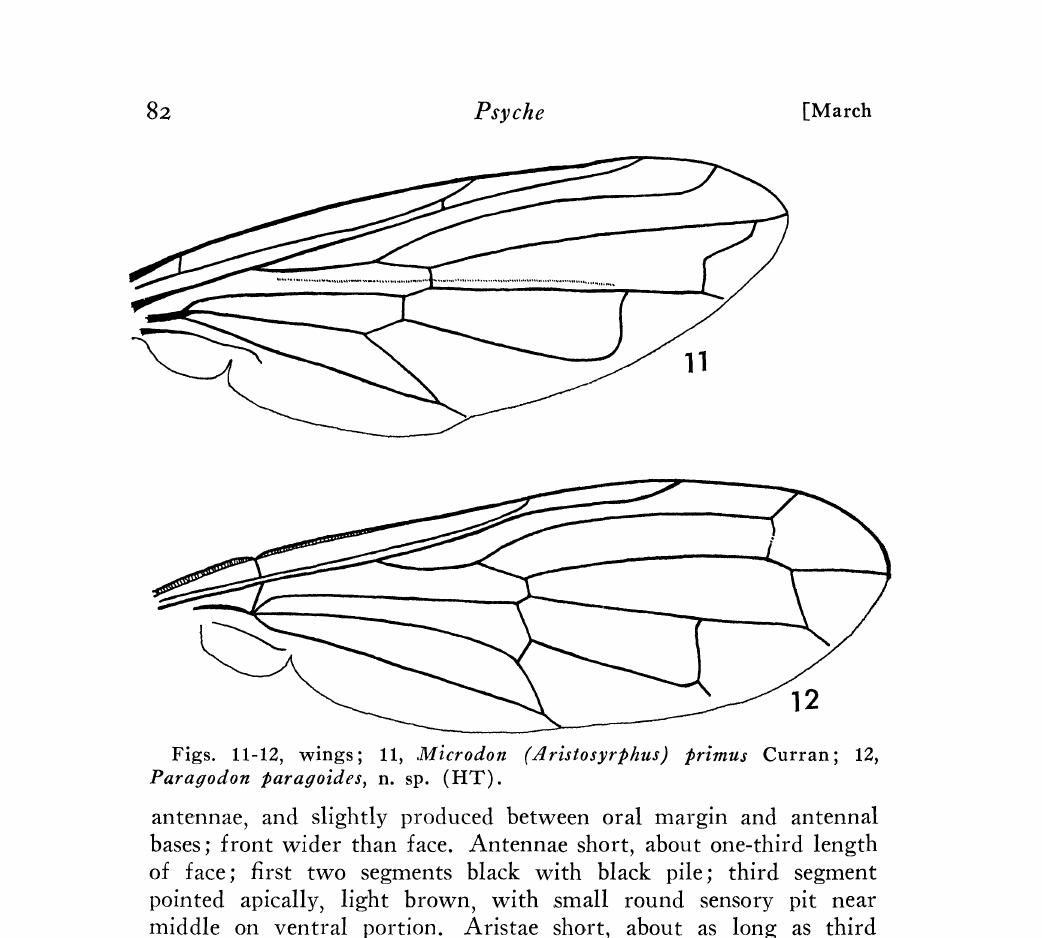
Figs. 11-12, wings; 11, .Microdon (dristosyrlhus) lrimus Curran; 12, Parayodon arayoides, n. sp. (HT). antennae, and slightly produced between oral margin and antennal bases; front wider than ace. Antennae short, about one-third length of ace; /]rst two segments, black with black pile; third segment pointed apically, light brown, with small round sensory pit near middle on ventral portion. Aristae short, about as long as third segment, thick, light brown. Antennal ratio: 2:1:6. Thorax: brownish black except for humeri, postalar calli and dorsal surface of stenopleura dirty white; thoracic pile yellow except or o black pile above each wing base. transverse J-shaped spot Wings grayish, almost completely microtrichose, with bases o (irst and second basal cell bare; wing venation as figured (Fig. Halteres yellow. Squamae gray with dark margins. Legs black o emora, ront our tibiae, and all tarsi except as ollows: tips orange; with pile dark except or light pile on ront our tibiae. Abdomen: Dorsum with black and yellow pattern as tqgured (Fig. 9); venter yellow; abdominal pile appressed black on black areas and pale yellow on yellow areas. Genitalia: as /]gured (Fig. 7, 7a)